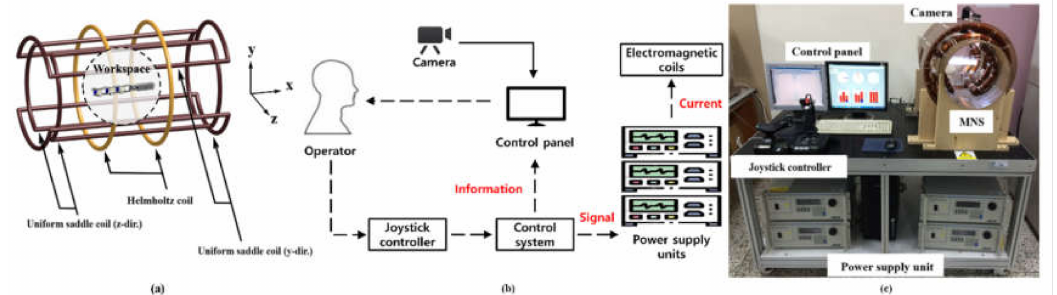
Figure 2. ( a ) MNS composed of a Helmholtz coil and two uniform saddle coils to generate an external precessional magnetic field. ( b ) Control workflows of the MNS. ( c ) Constructed MNS and experimental